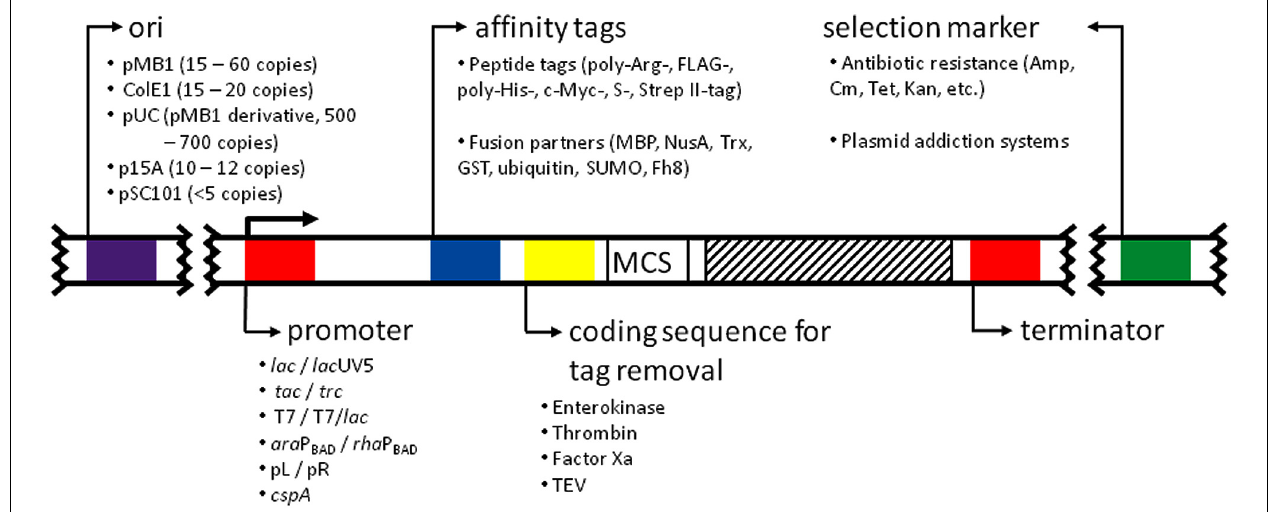
FIGURE 1 |Anatomy of an expression vector.The figure depicts the major features present in common expression vectors. All of them are described in the text.The affinity tags and coding sequences for their removal were positioned arbitrarily at the N-terminus for simplicity. MCS, multiple cloning site. Striped patterned box: coding sequence for the desired